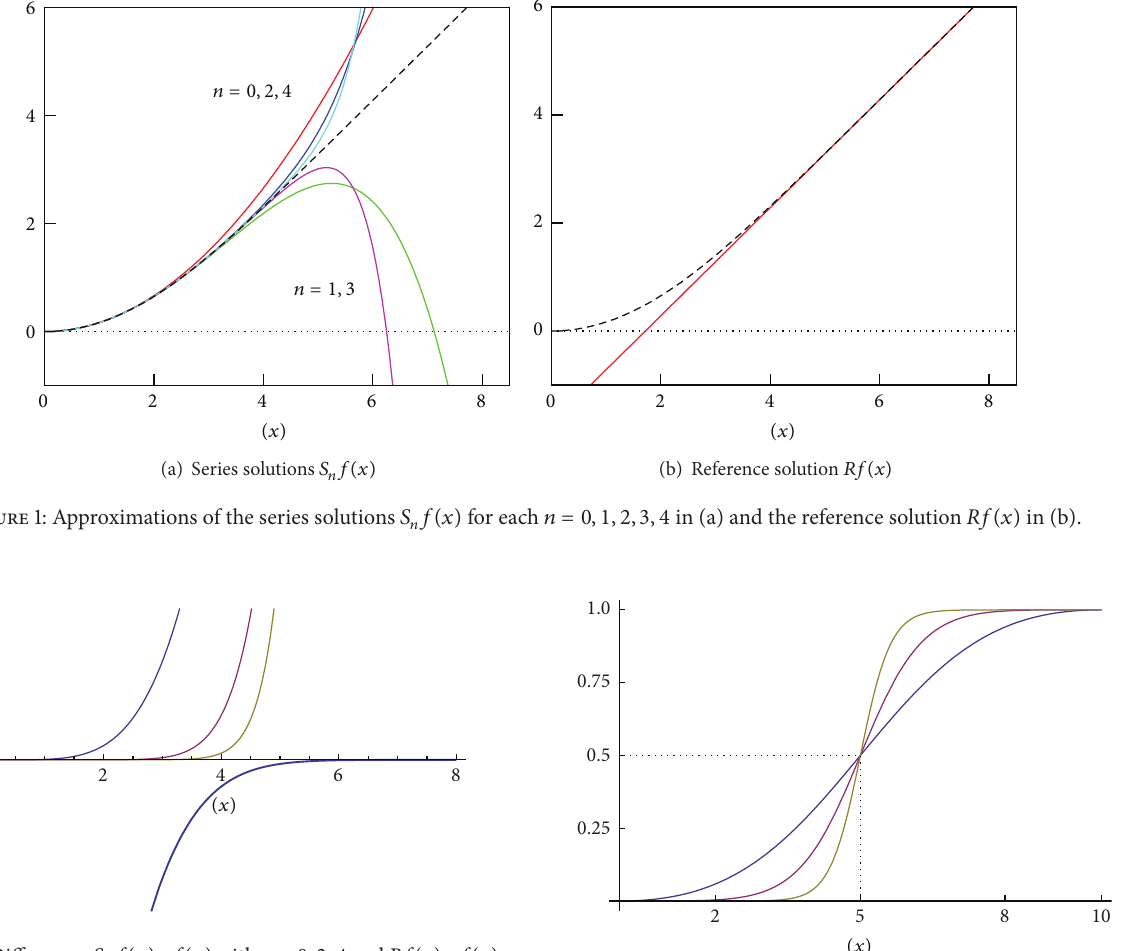
Figure2:Differences 𝑆 𝑛 𝑓(𝑥)−𝑓(𝑥) with 𝑛 = 0,2, 4 and 𝑅𝑓(𝑥)−𝑓(𝑥) indicated by the thin lines and the thick line, respectively.